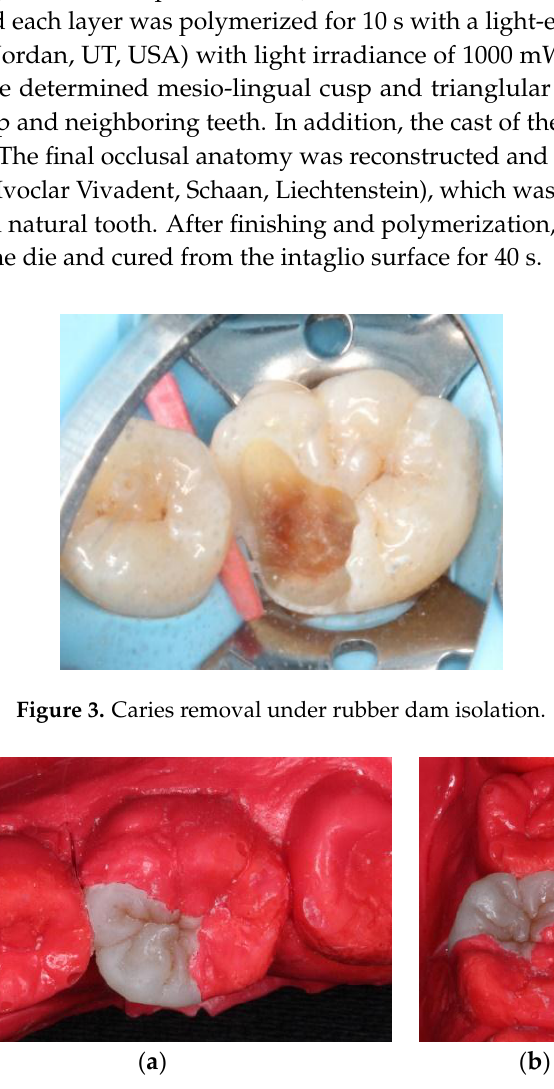
Figure 4. Composite onlay fabricated on silicone die: ( a ) occlusal view; and ( b ) mesial view.